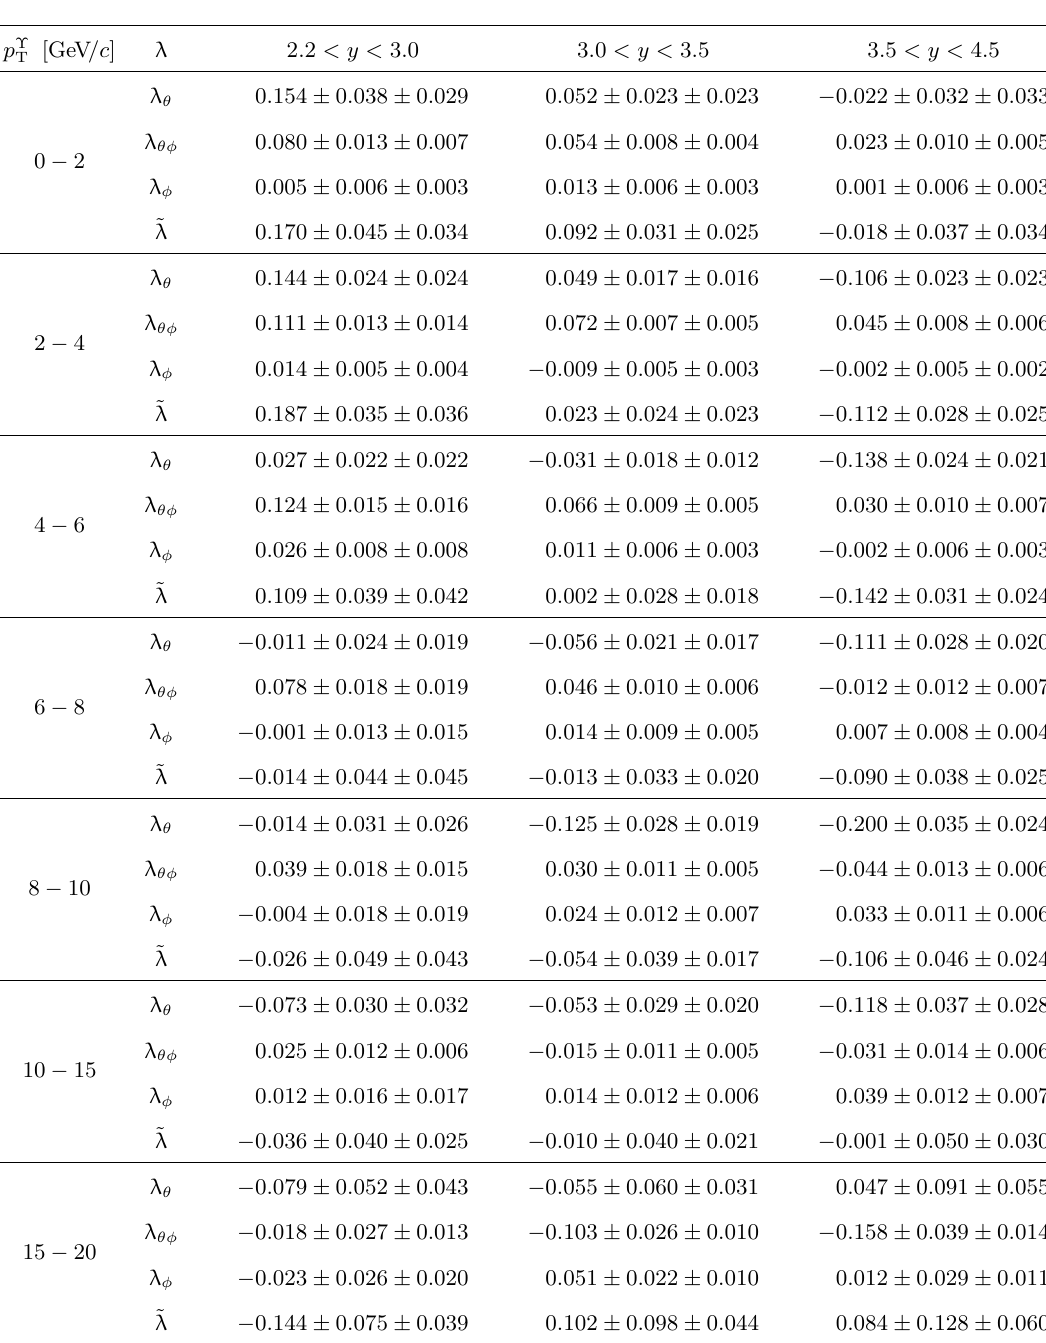
Table 7 . Values of (cid:21) (cid:18) , (cid:21) (cid:18)(cid:30) , (cid:21) (cid:30) and ~ (cid:21) measured in the GJ frame for the (cid:7)(1S) produced at p s = 8 TeV. The (cid:12)rst uncertainty is statistical and the second systematic.